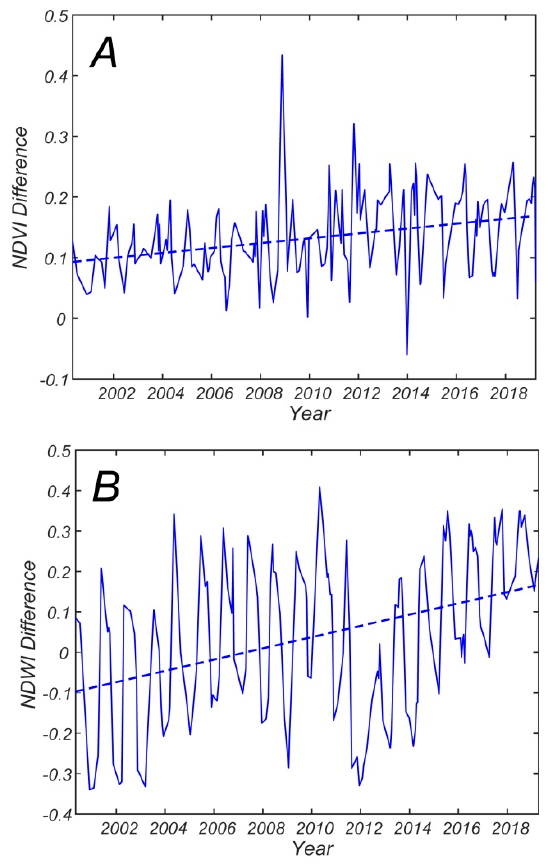
Figure 9. ( A ) Di ff erence between average NDVI in regenerative and persistence forest. ( B ) Di ff erence Figure 9. ( A ) Difference between average NDVI in regenerative and persistence forest. ( B ) Difference between average NDWI in regenerative and persistence between average NDWI in regenerative and persistence forest.